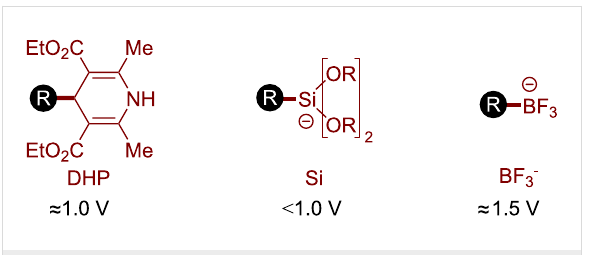
Figure 2: Common substrates for the photocatalytic oxidative genera- tion of C(sp 3 )